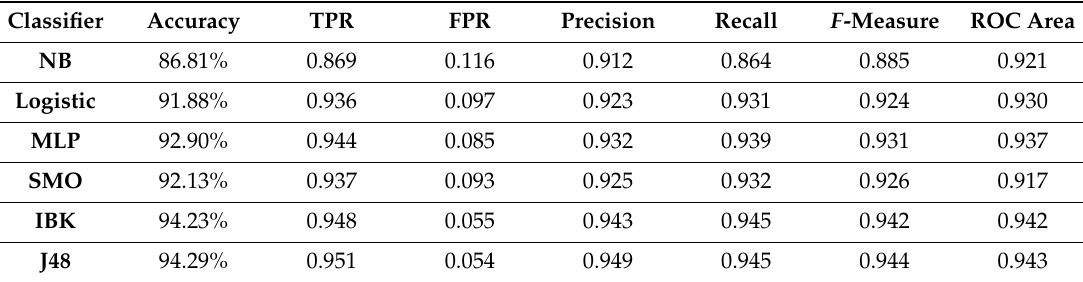
Table 4. Phase 1 examination results.